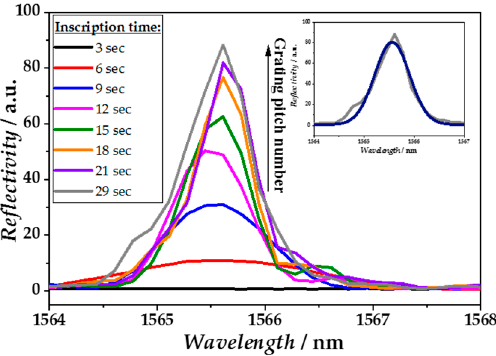
Figure 3. Reflection spectra of λ B with increasing intensities indicating higher grating reflectivity; measured at different time points during the point ‐ by ‐ point inscription process. Inset: Recorded spectrum for 29 s, together with Gaussian fit.